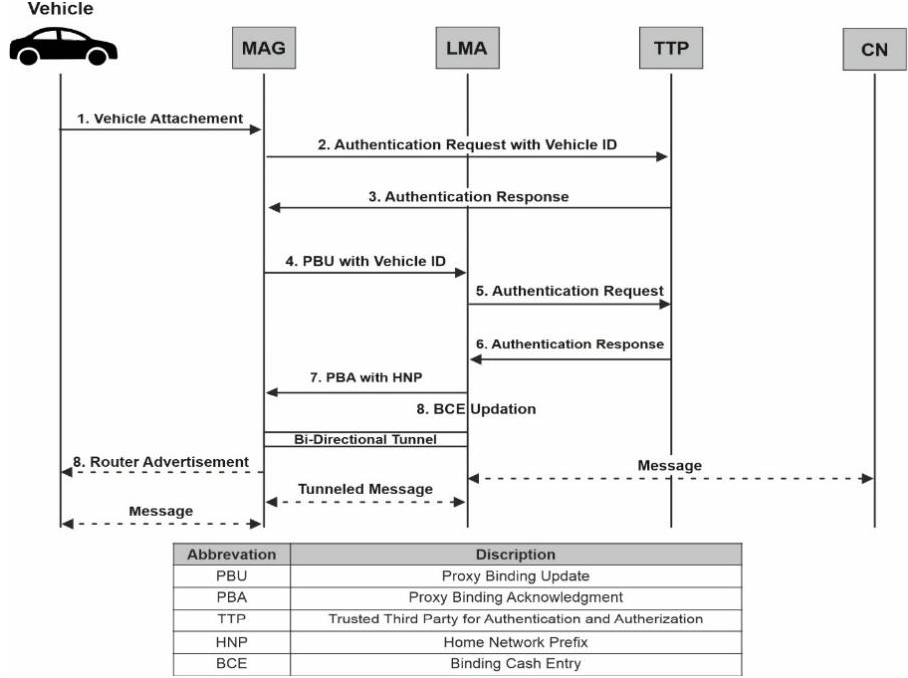
Figure 4. Communication Sequence Diagram in PMIPv6 for VANET.